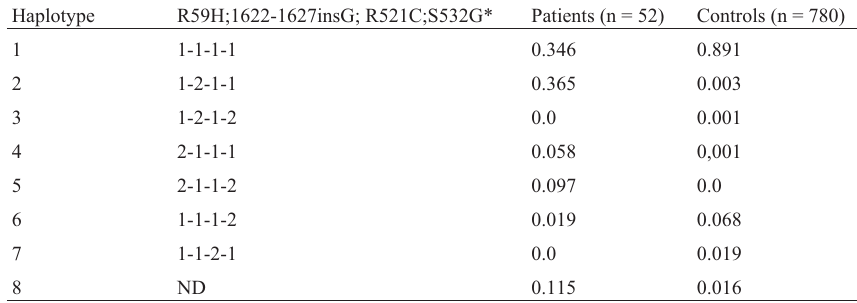
Table 2 - Haplotype frequencies (as to the presence of R59H and 1622-1627insG mutations and R521C and S532G polymorphisms) in patients and con- trols.